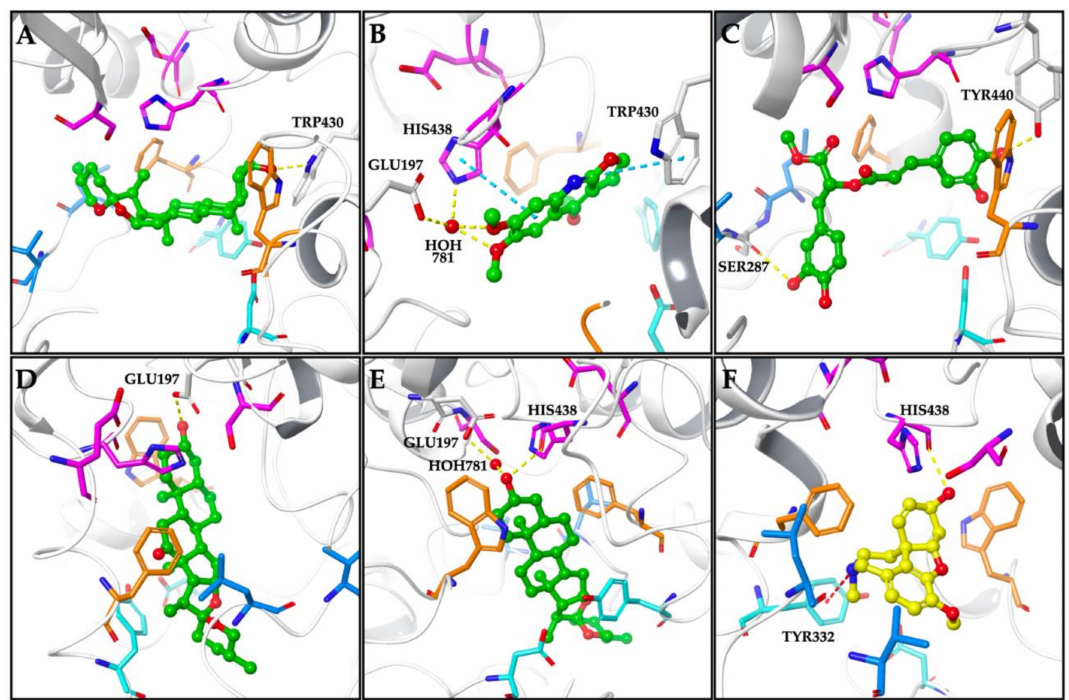
Figure 3. Proposed binding modes for smilagenin ( A ), kokusaginine ( B ), methyl rosmarinate ( C ), hecogenin ( D ), tigogenin ( E ), and galanthamine ( F ) in the hBChE active site (PDB: 4TPK). The compounds are presented as green and yellow ball and stick models. The regions comprising the residues are colored as follows; catalytic triad: magenta, oxyanion hole: orange, acyl binding site: blue, peripheral anionic site: cyan. Hydrogen bonds, π - π stacking contacts, and π -cation contacts are represented by yellow-, cyan-, and red-dashed lines, respectively.